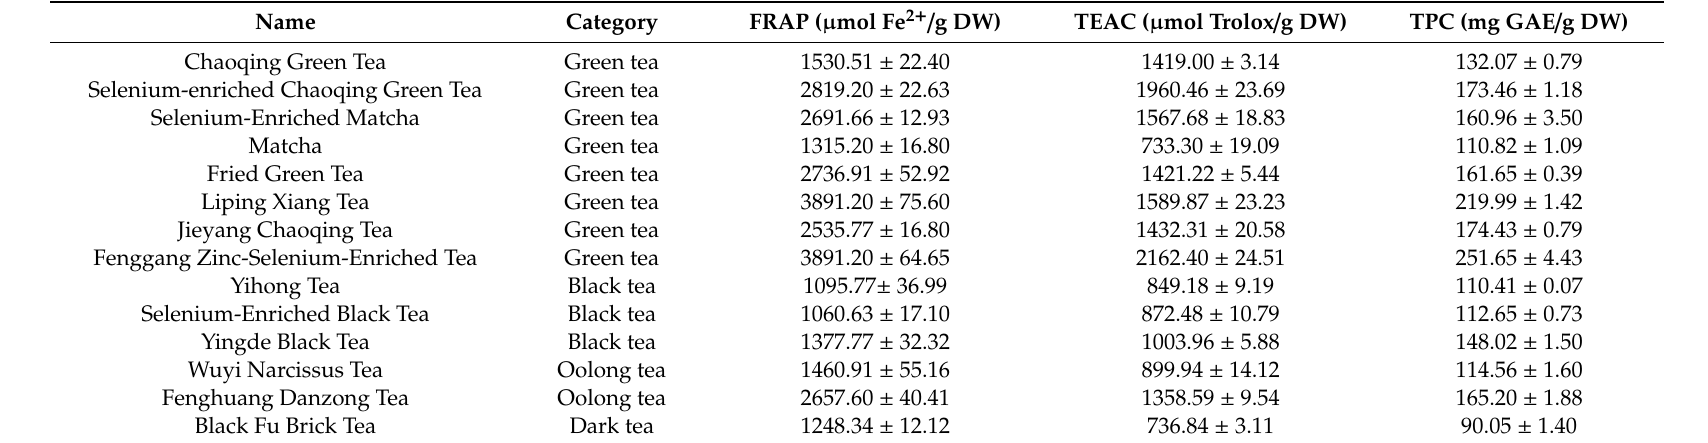
Table 4. The in vitro antioxidant capacities and total phenolic contents of selected